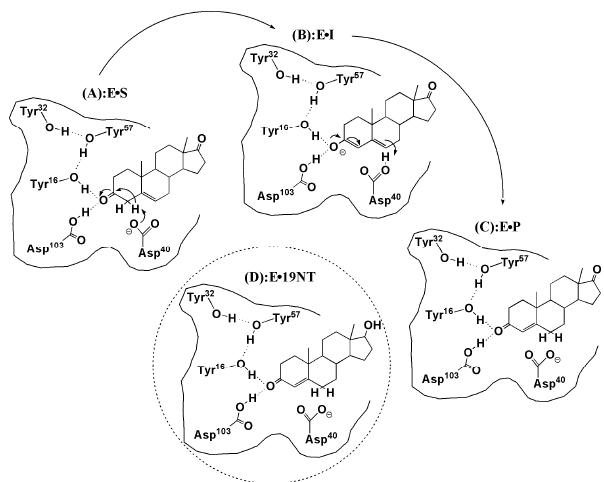
Figure 1. Mechanism of the isomerization reaction catalyzed by ketosteroid isomerase (KSI) and the product-like inhibitor, 19-nortestosterone (19-NT). ( A ) E ∙ S is the enzyme (E) and 5-androstene-3, 17-dione (S, substrate). ( B ) The intermediate state (I), the formation of an enolate with a negative charge, is stabilized by the H-bond network formed by the Tyr16 and Asp103. ( C ) E ∙ P is the enzyme and 4-androstene-3, 17-dione (P, product). ( D ) The complex between the enzyme (KSI) and inhibitor 19-NT (E ∙ 19-NT) that has the same bound state as the natural substrate.